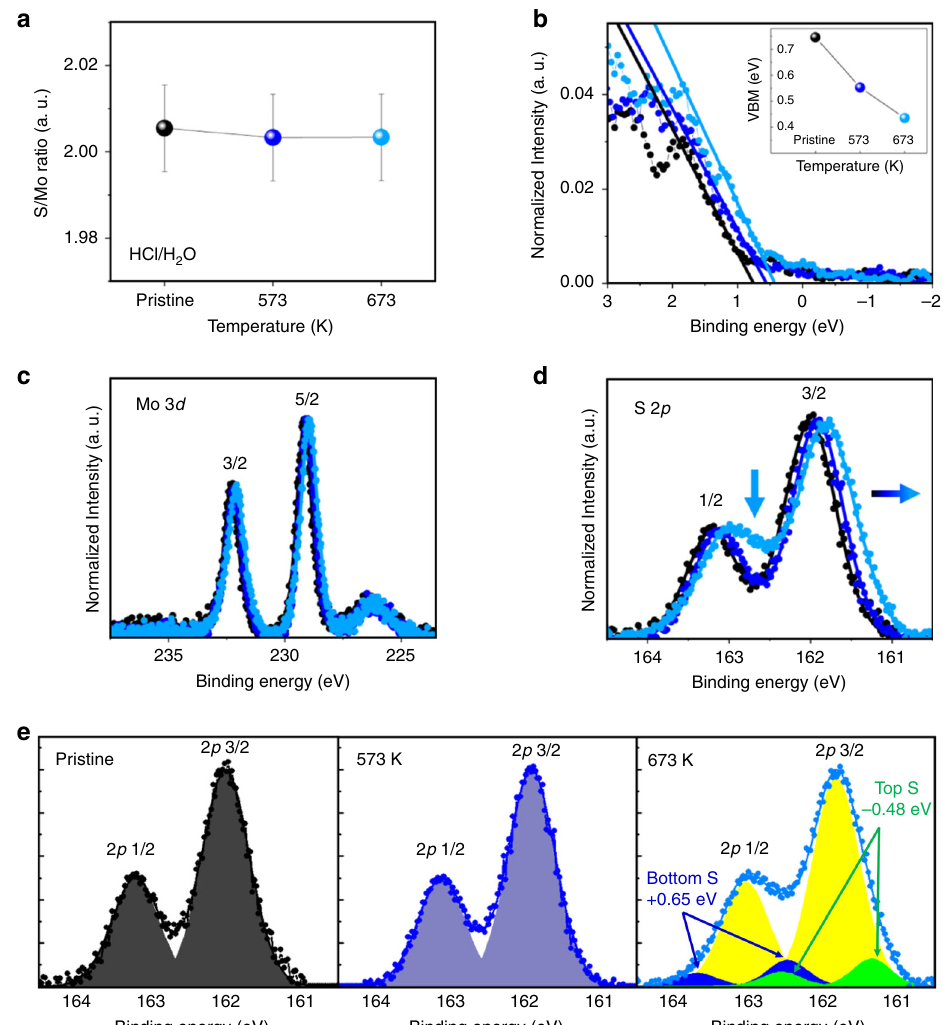
Fig. 2 XPS of multilayer exfoliated MoS 2 heated in HCl/H 2 O atmosphere. a Stoichiometry of exfoliated multilayer MoS 2 samples in pristine conditions (data in black) and heated at two temperatures (573 K, data in blue and 673 K, data in cyan) in HCl/H 2 O atmosphere. The error bar is determined via different spectra measured for each condition. b Valence band (VB) spectra (normalized to area) close to the Fermi edge for the same samples. The inset shows that the valence band maximum (VBM), as measured from the Fermi level, shifts toward the Fermi edge with increasing temperature. VBM is obtained from the intersection with zero of the linear fi t of the leading edge region in the VB spectra. c Mo 3 d and d S 2 p core-level spectra for the three samples, from which the S/Mo ratio is obtained. The horizontal arrow in ( d ) indicates the direction of the S 2p core-level shift toward lower binding energy with increasing p-character and temperature, while the vertical arrow indicates the region where the S 2p spectrum at 673 K is different from those of the pristine material and exfoliated MoS 2 heated at 573 K. e Fit of S 2p core levels for pristine sample (left), sample heated at 573 K (middle), sample heated at 673 K (right), where two additional doublets are used for the fi